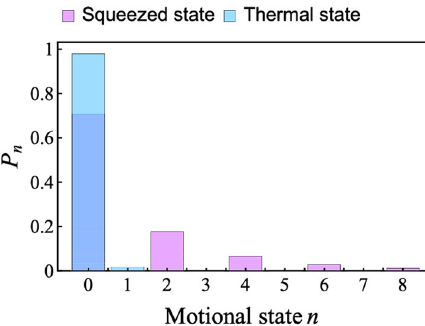
Fig. 3 Phonon number distribution P n for a squeezed state (yel- low) and thermal state (light blue) at very low temperatures (average phonon number ¯ n = 0 . 02). The squeezing parameter is assumed to be λ ≈ 0 . 88. The vacuum squeezed state is created by the action of the L t Hamiltonian (1) on the phonon vacuum. Although there are no phonons at the beginning, phonons are created during the evolution, as a result of the analogue of Hawking